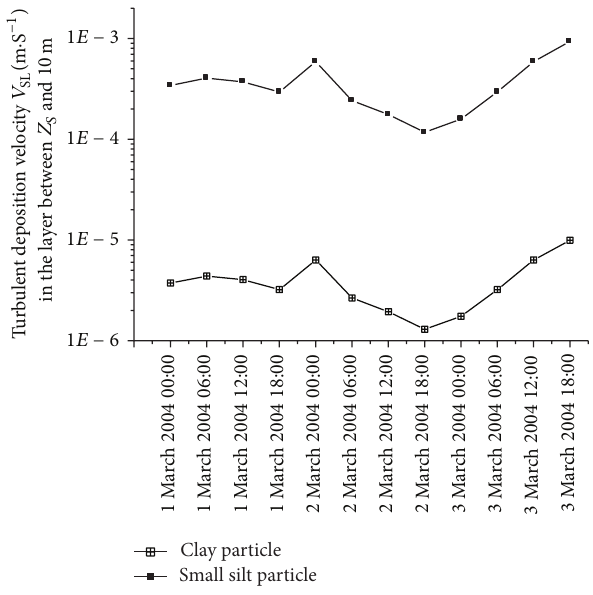
Figure 8: Evolution of turbulent deposition velocity of both clay and small silt particles between the layer 𝑧 𝑠 and 10 meters above the Island of Gran Canaria from 1 to 3 March 2004.